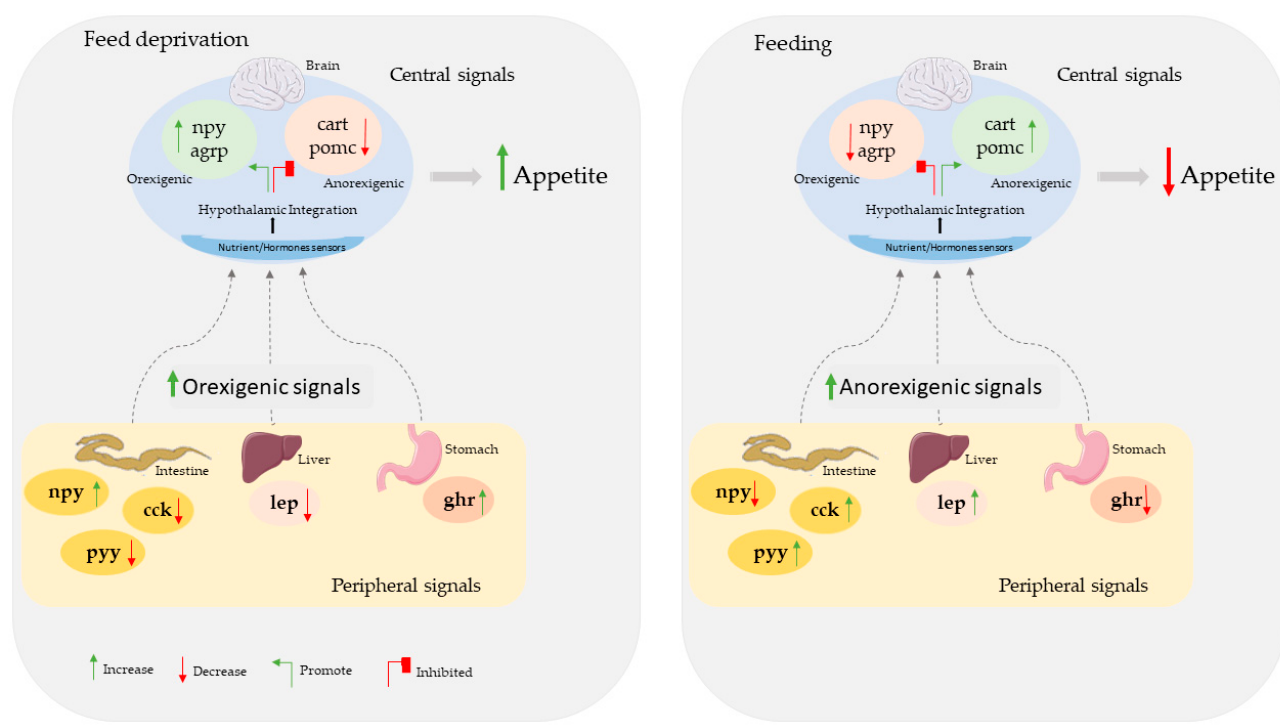
Figure 1. Diagram showing the interaction of peptides and hormones at the central level (brain) and peripheral levels (intestine, liver, and stomach) involved in the regulation of food intake in fish and how they can be affected by feeding deprivation and feeding. agrp: Agouti ‐ related peptide; cart: cocaine ‐ and amphetamine ‐ regulated transcript; cck: cholecystokinin; npy: neuropeptide Y; pomc: proopiomelanocortin; pyy: peptide YY; ghr: ghrelin.